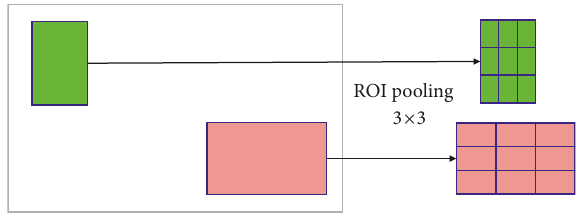
Figure 11: The structure of the ROI pooling layer.